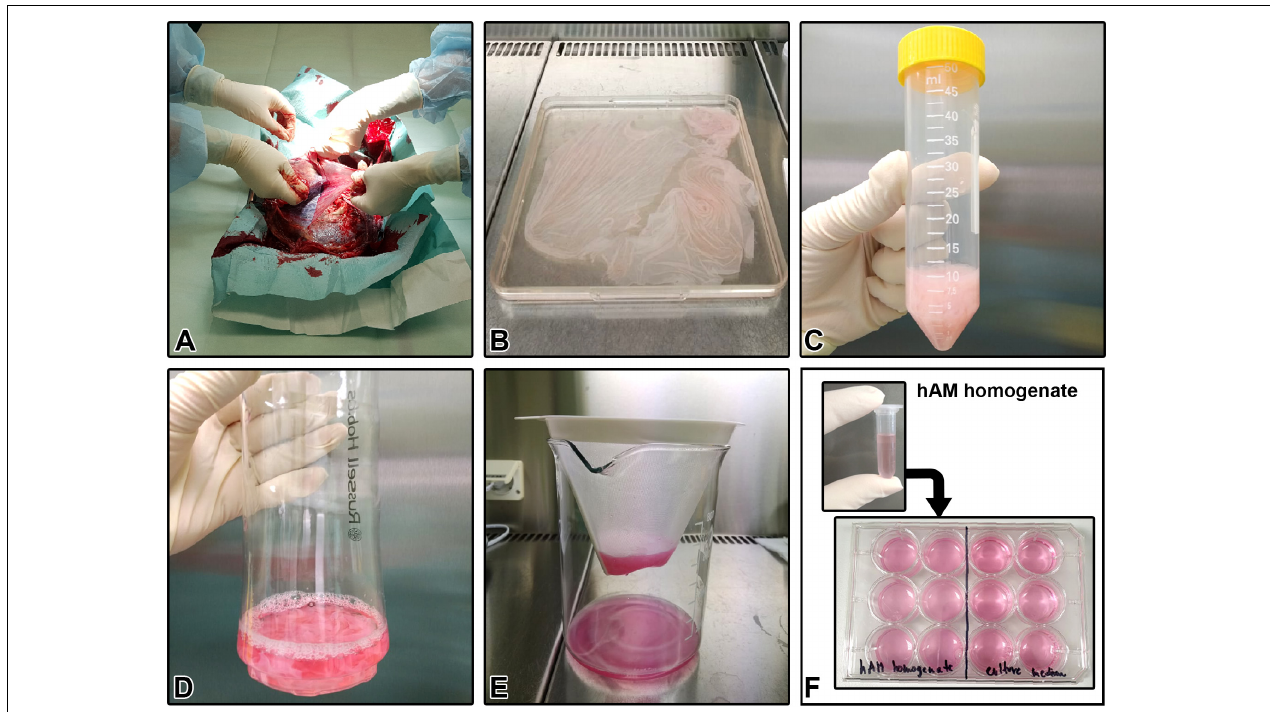
FIGURE 1 | Human amniotic membrane (hAM) homogenate preparation protocol. (A) Separation of the hAM from human chorionic membrane (hCM). (B) Washing the hAM in sterile PBS. (C) Measuring the volume of hAM pieces. (D) Addition of an appropriate culture medium to the hAM pieces in the ratio of 1:4. (E) Filtration of hAM homogenate through sterile nylon membrane filter with pore size < 1 mm, after completed homogenization. (F) Cryopreserved hAM homogenate is used for further